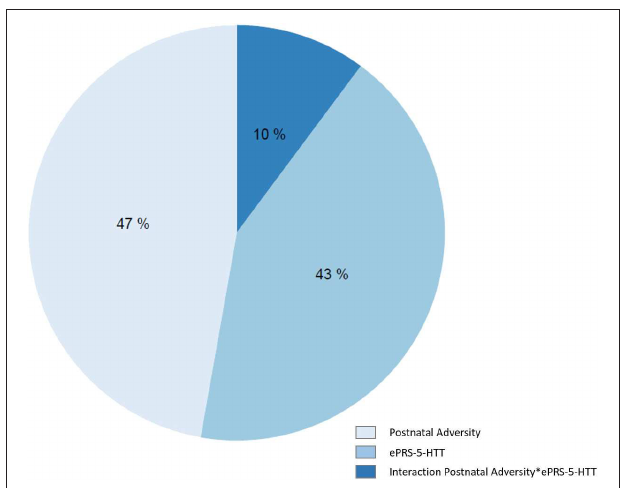
FIGURE 4 | Variations in DNA methylation levels were predicted by postnatal adversity score, ePRS-5-HTT, and the interaction between postnatal adversity score and ePRS-5-HTT. Each variable on chart denotes one model. AIC was used to compare three models for each CpG and select the best one. Percentages on chart represent the number of CpGs that are best explained (lowest AIC) by a specific model. All models were adjusted for population stratification and